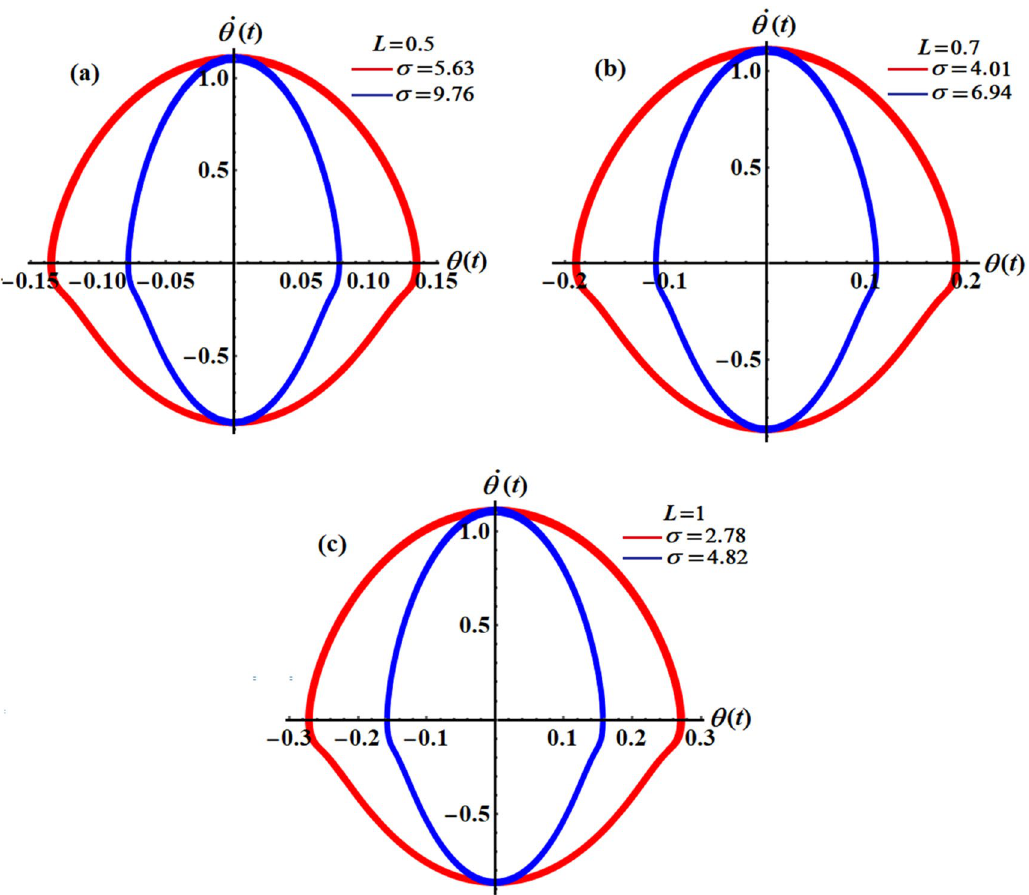
˙ θ at: ( a ) L = 0.5, σ( = 5.63, 9.76 ) , ( b )